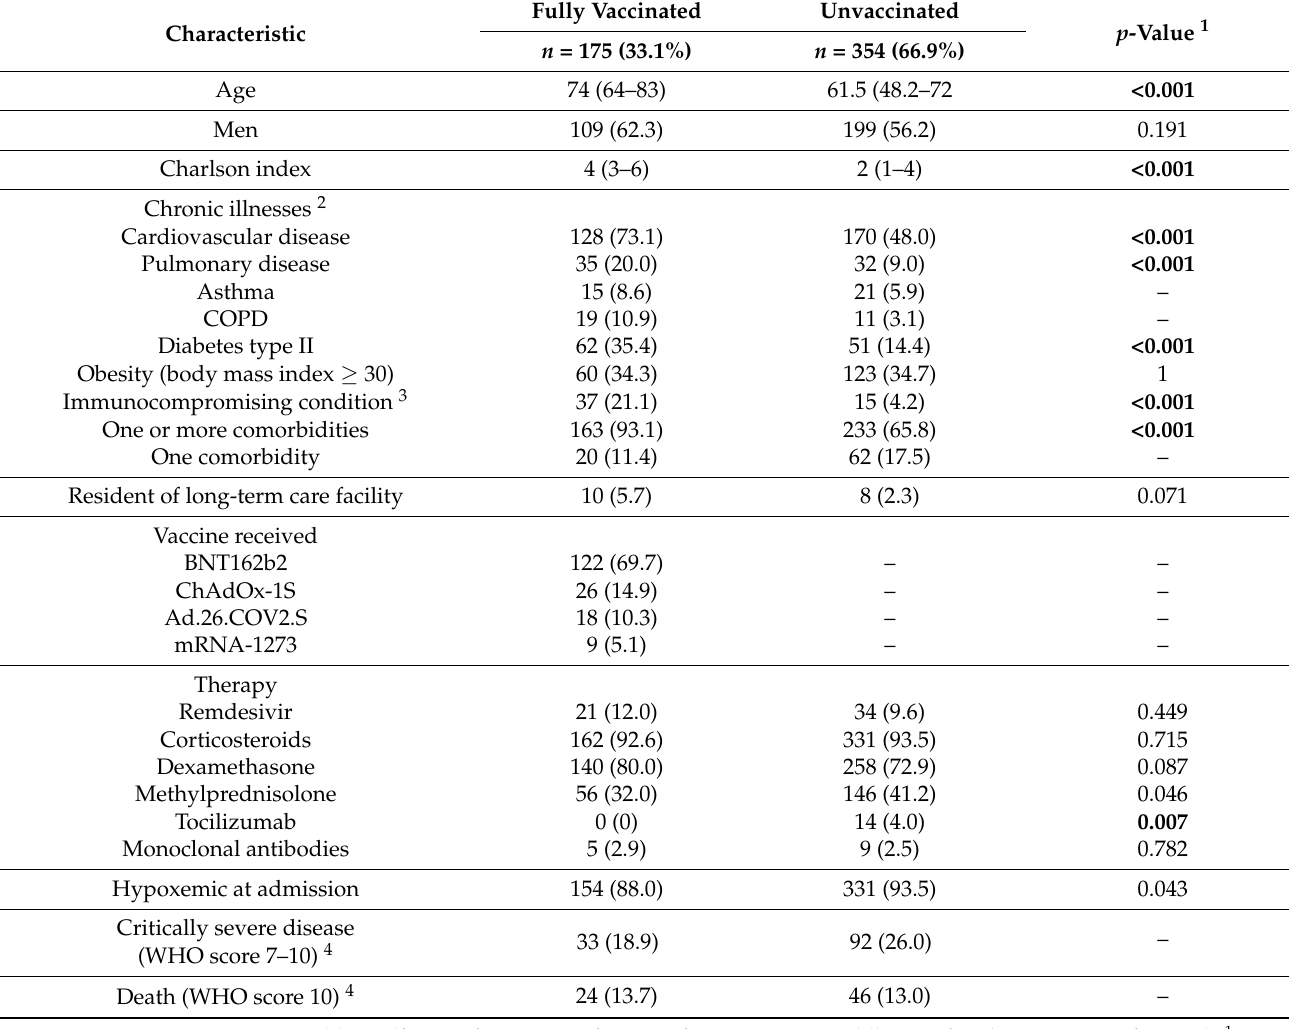
Table 1. Characteristics of patients hospitalized for COVID-19 by vaccination